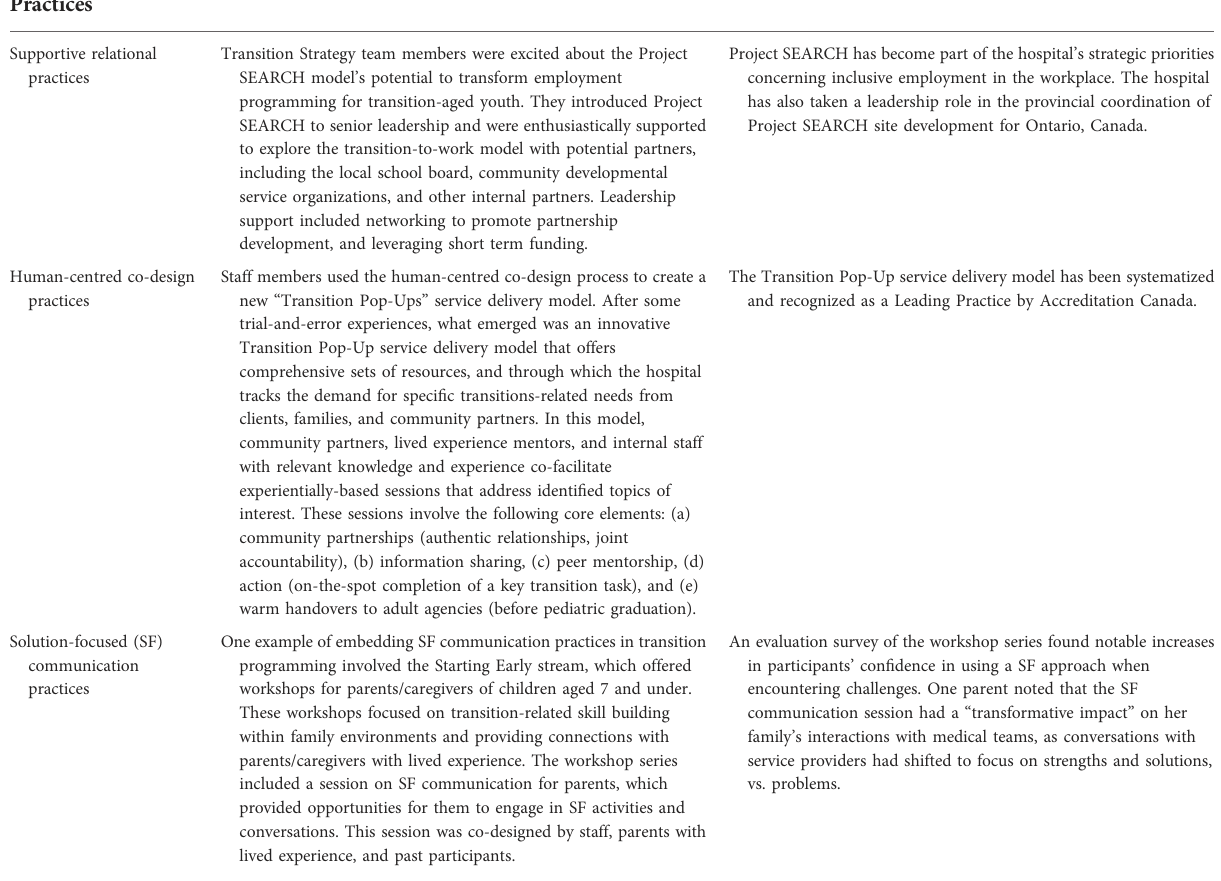
TABLE 2 Illustrations of effective team